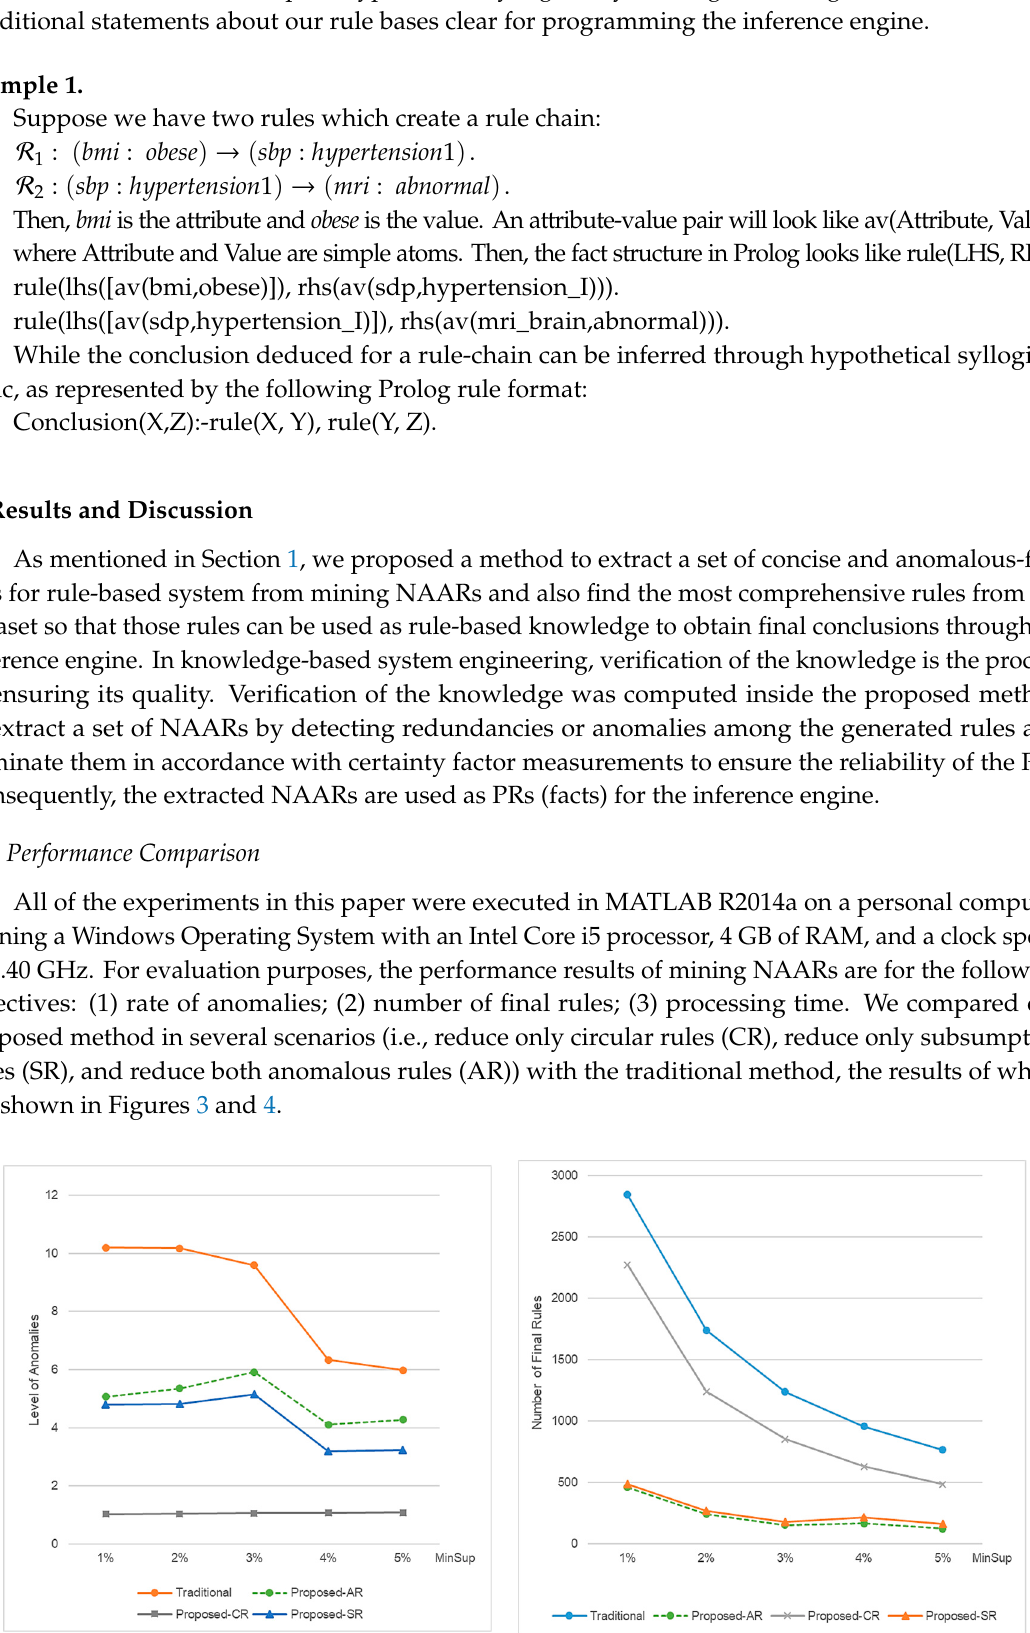
Figure 4. The performance comparison of processing time. 3.2. Subsumption Checking The proposed method provides clear and understandable information about the inconsistencies found in the rule-base and verifies every rule with another set of rules to find redundancies. To ensure that the extracted PRs is consistent, this study focused on reducing subsumption and circular rules. Regarding [27], the proper rule and its corresponding sub-antecedent have the same consequent itemset, while the proper rule and its corresponding sub-consequent have the same antecedent itemset. In these conditions, a proper rule might have subset items in other rules, which can lead to the occurrence of redundant rules. Hence, it is necessary to eliminate either the proper rule or its corresponding sub- antecedent/consequent when the certainty factor of one rule is higher than the other. For instance, Table 4 shows an example of subsumption rules detected by rule IDs 14, 90, 134, and 350 which contained subset items of its proper rule (rule 350) and have the same consequent item set (𝑚𝑟𝑖: 𝐴𝑏𝑛𝑜𝑟𝑚𝑎𝑙) . Regarding certainty factor values of the rules shown in the table, we can see that all the rules in the sub-antecedent group are lower that its proper rule. This implies that a single proper rule (rule 350) is sufficient to express the knowledge or the meaning of the three sub- antecedent rules. Therefore, the proper rule is more comprehensive than its sub-antecedent rules. In